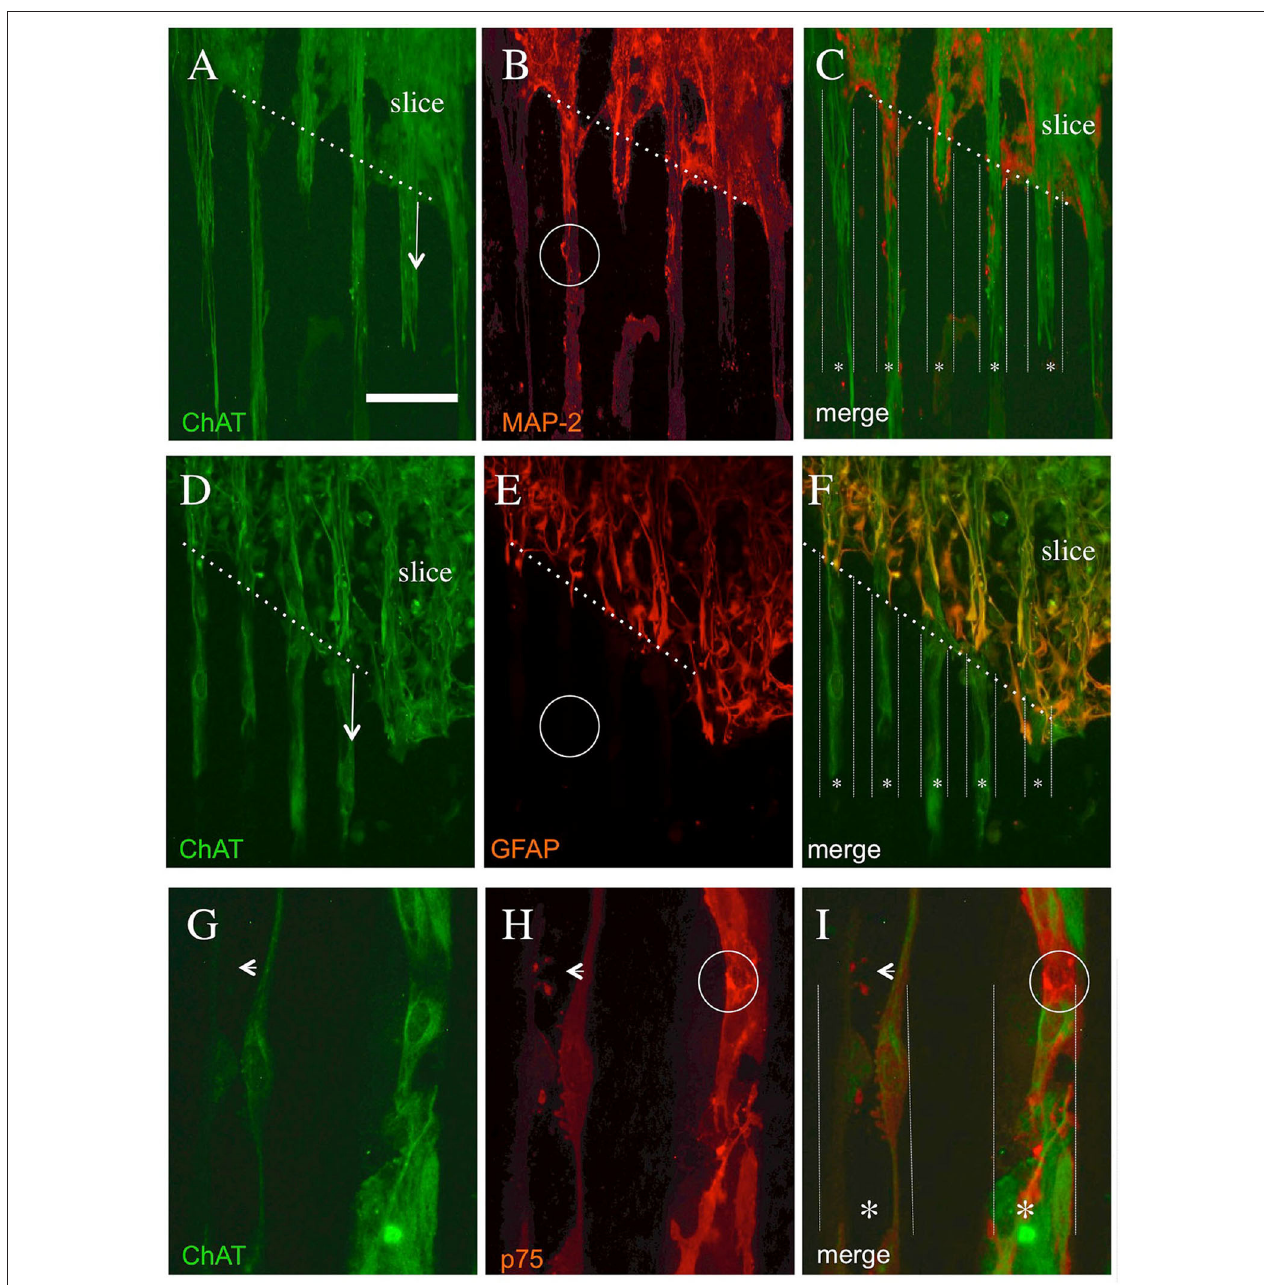
FIGURE 5 | Co-localization of cholinergic neurons stained with ChAT (A,D,G) and with microtubule-associated protein-2 [MAP-2, (B) ] or glial fibrillary acidic protein [GFAP, (E) ] or the low-affinity NGF receptor p75 NTR (H) . Brain slices were cultured on NGF µ CP for 3 weeks, fixed, and stained for ChAT (Alexa-488, green) and MAP-2, GFAP, or p75 NTR (Alexa-546, red). The merged pictures (C,F,I) show the orientation of the slices, the borders (white thick dotted lines), and the suggested µ CP lanes (white small dotted lines with a star *). (A) The ChAT + processes (six lanes) grew out of the slice (arrow) along the µ CP. (B) The MAP-2 + processes which fully co-localized with the ChAT + processes and display a differential expression intensity [see as an example the white circle in (B) ]. (D) ChAT + processes (4 lanes) growing out of the slices (arrow) along the µ CP. (E) shows intense GFAP + staining within the brain slices, more extensive at the borders representing reactive astrogliosis, but nearly no immunopositive processes outside the slices [see the white circle in (E) ]. (G) The immunostaining of two selected ChAT + processes along a µ CP, which fully co-localizes with the p75 NTR neurotrophin receptor (H) . The small arrow in (G–I) point to strong differential p75 NTR immunoreactive varicosities (probably synaptic processes) within the ChAT + processes, but also strong neuronal immunoreactive areas [white circle in (H,I) ] are found. Note that all these stainings do not come from the same slice, but from four to six brain slices prepared from two to five animals. Scale bar in A = 180 µ m (A–F) , 36 µ m (G–I) .